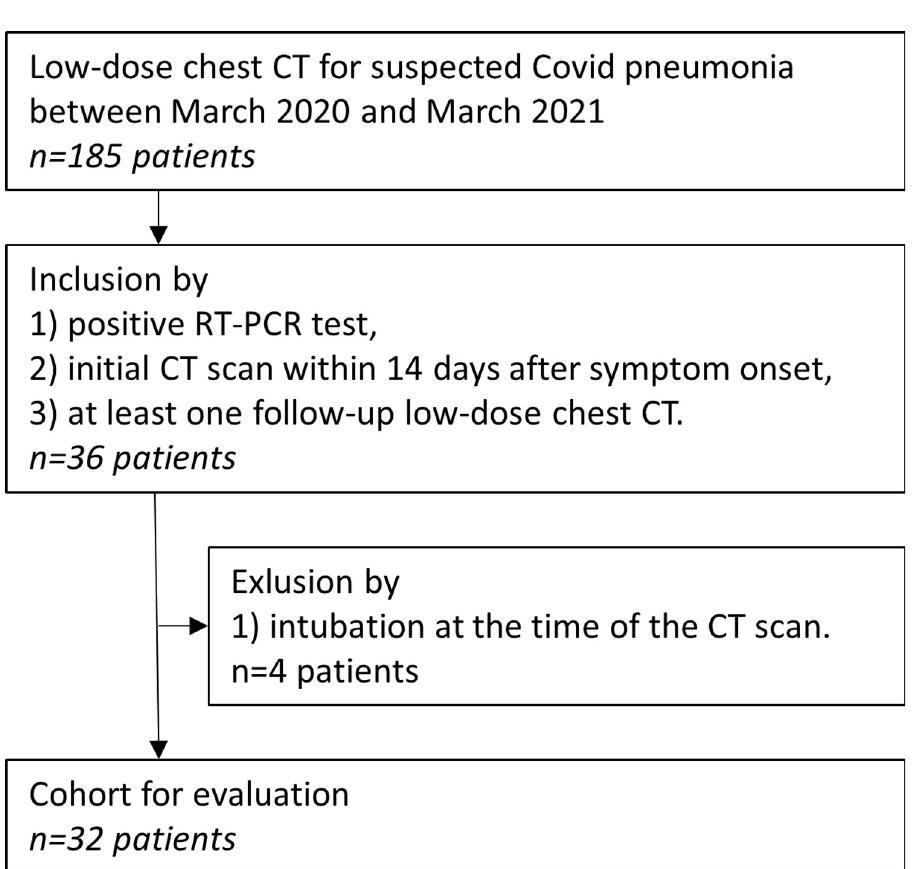
Fig 1. Inclusion chart of